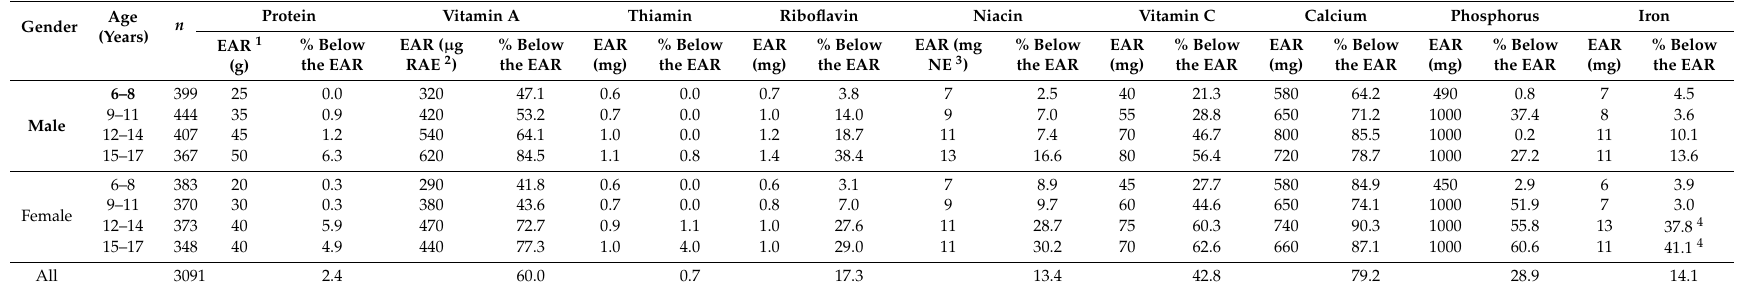
Table 4. The proportion of Korean school-aged children and adolescents with insu ffi cient nutrient intake.